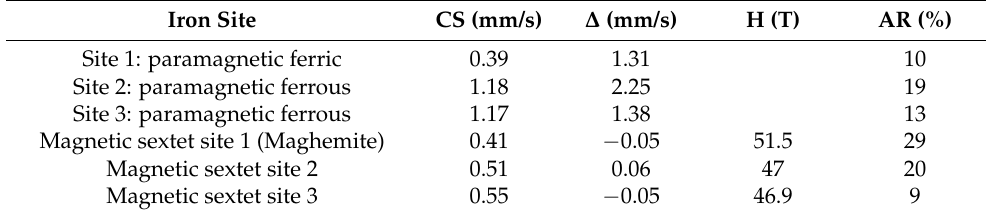
Table 3. Mössbauer parameters and distribution of magnetic and paramagnetic fractions from Mössbauer spectroscopy results of EAF slag at 140 K.